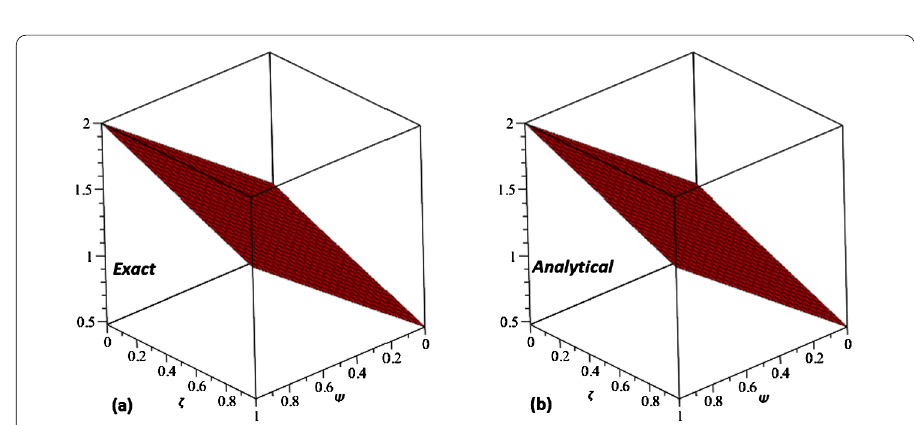
Figure 8 The ν -solution graph of example 3, ( a ) exact solution and ( b ) ETDM solution at δ = 1